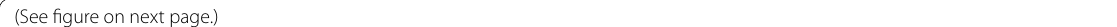
figure on next Fig. 4 Influence of Staphylococcus_xylosus and Staphylococcus_lentus in the occurrence of BT. The pure cultures (10 9 CFU) of the two kinds of gut microbiota ( Staphylococcus_lentus and Staphylococcus_xylosus ) were given to mice by gavage to make them become the dominant microflora in the intestine, and then the liver fibrosis model of mice was induced by intraperitoneal injection of CCl 4 (0.5 µL/g). A After bacterial colony culture on mesenteric lymph nodes (MLNs), the occurrence of the colonies was observed. B Statistical analysis on the number of bacterial colonies, one-way ANOVA with Tukey’s post-hoc. N 10. C Analysis of the concentration of LBP in the mouse blood samples by a commercial kit. N 10. D The = = occurrence of BT was assessed using EUB338 FISH detection. N 10. E The mRNA levels of zonula occludens-1 (ZO-1) and occludin were measured = by qRT-PCR. N 10. F The relative ZO-1 positive areas were measured using immunofluorescence (scale bar 50 µm), one-way ANOVA with Tukey’s = = post-hoc. N 10. ** P < 0.01, *** P < 0.001, **** P < 0.0001 vs. Control. # P < 0.05, ## P < 0.01 vs. CCl 4 . Data are presented of three independent =